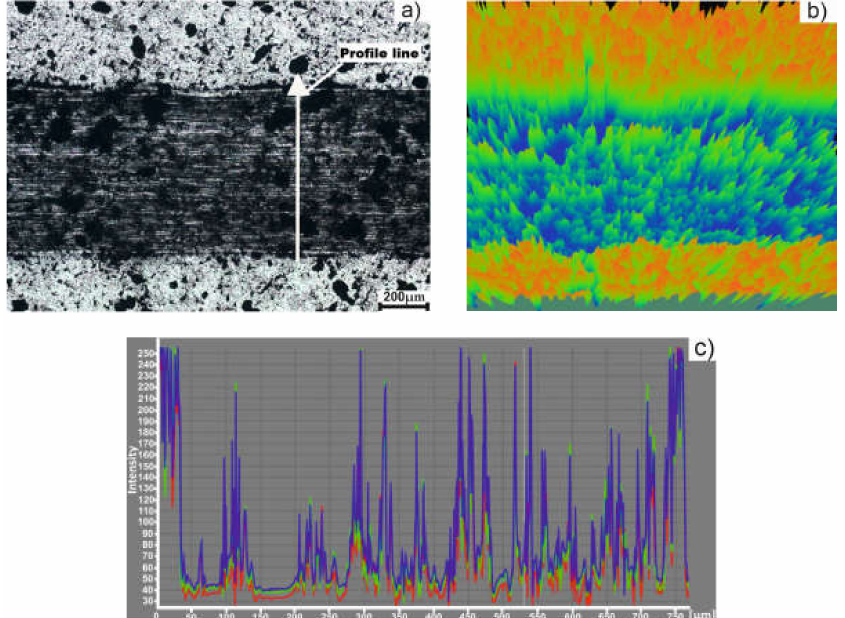
Figure 12. Sample obtained by TSS: ( a ) Worn track image (75X); ( b ) 3D image; ( c ) intensity profile.